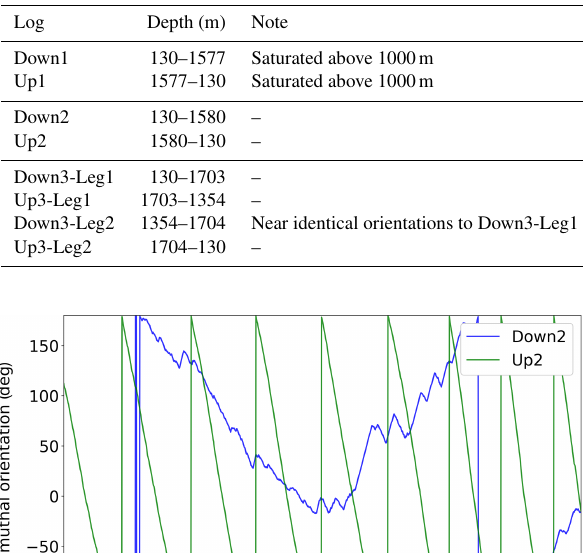
Table 1. Summary of usable logs obtained within the 2016/2017 and 2018/2019 logging seasons.